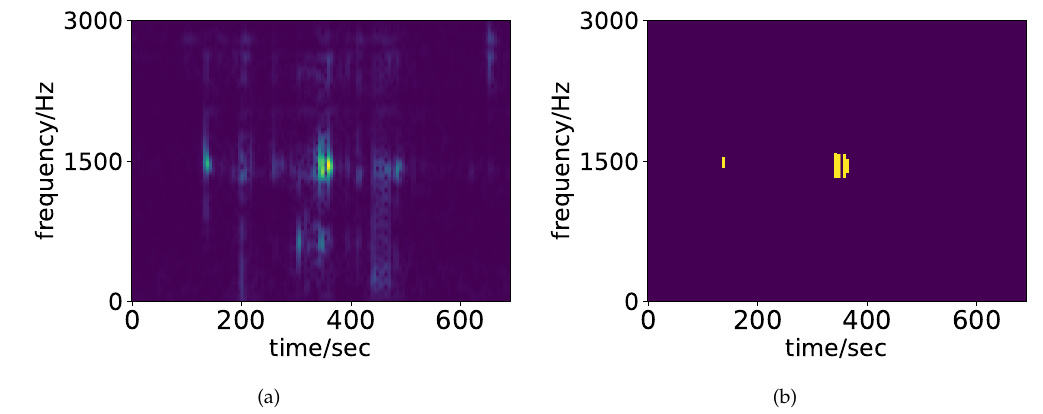
Figure 3. Example of a spectrogram ( a ) and its threshold version ( b